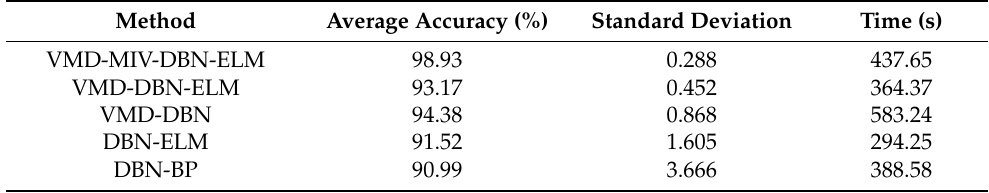
Table 3. Results of fault